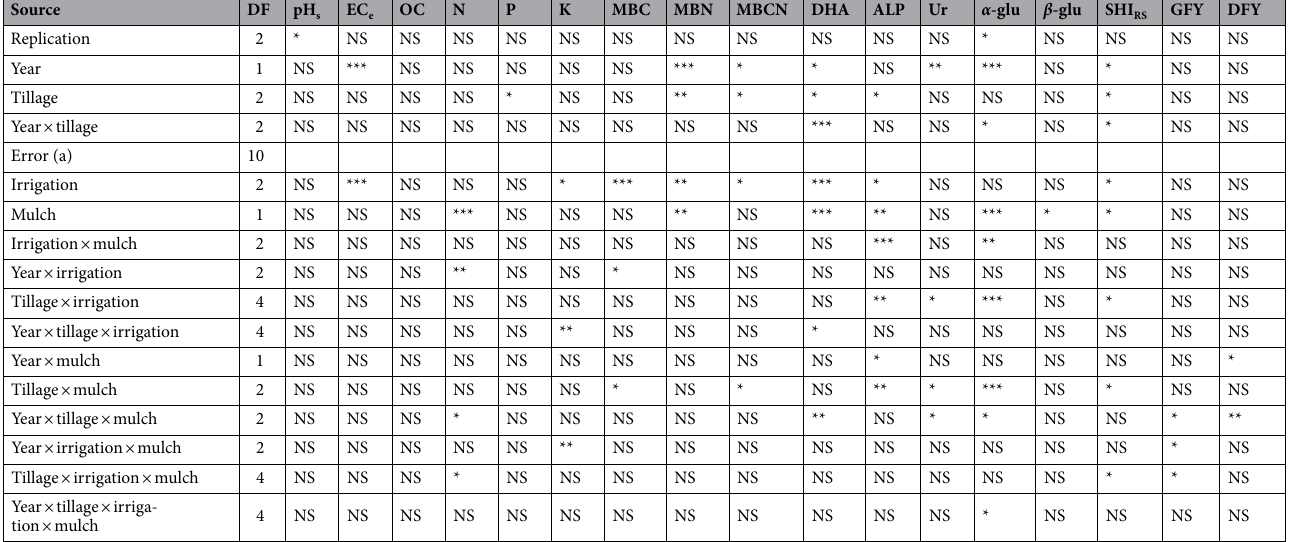
Table 2. Analysis of variance of tillage, mulch and saline irrigation on pH s , EC e , Walkley and Black oxidizable organic C (WBOC) and KMnO